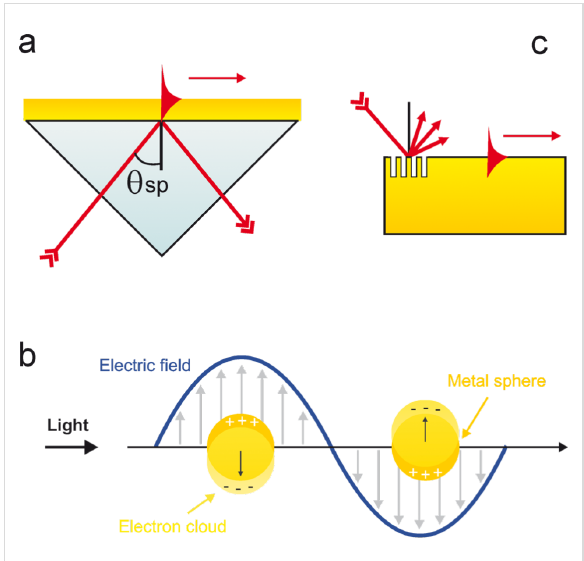
Figure 3: (a) Schematic representation of a SPP excitation (Kretschmann configuration) in which the plasmon mode propagates into a metal film adjacent to a prism. The incident angle should be accurately chosen so as to phase-match the momentums of the illumi- nated light and the SPP. (b) The excitation of a LSPR in nanoparticles confines the light energy into sub-wavelength volume, leading to strongly enhanced local electromagnetic field. (c) The excitation of a SPP can be coupled with the light diffraction on a